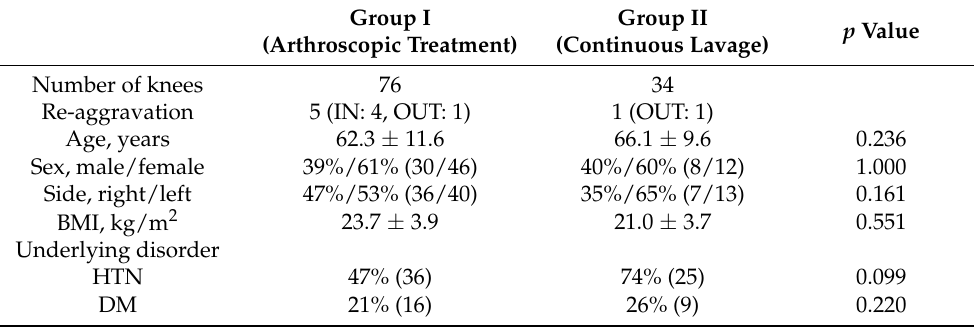
Table 1. Patient demographics.